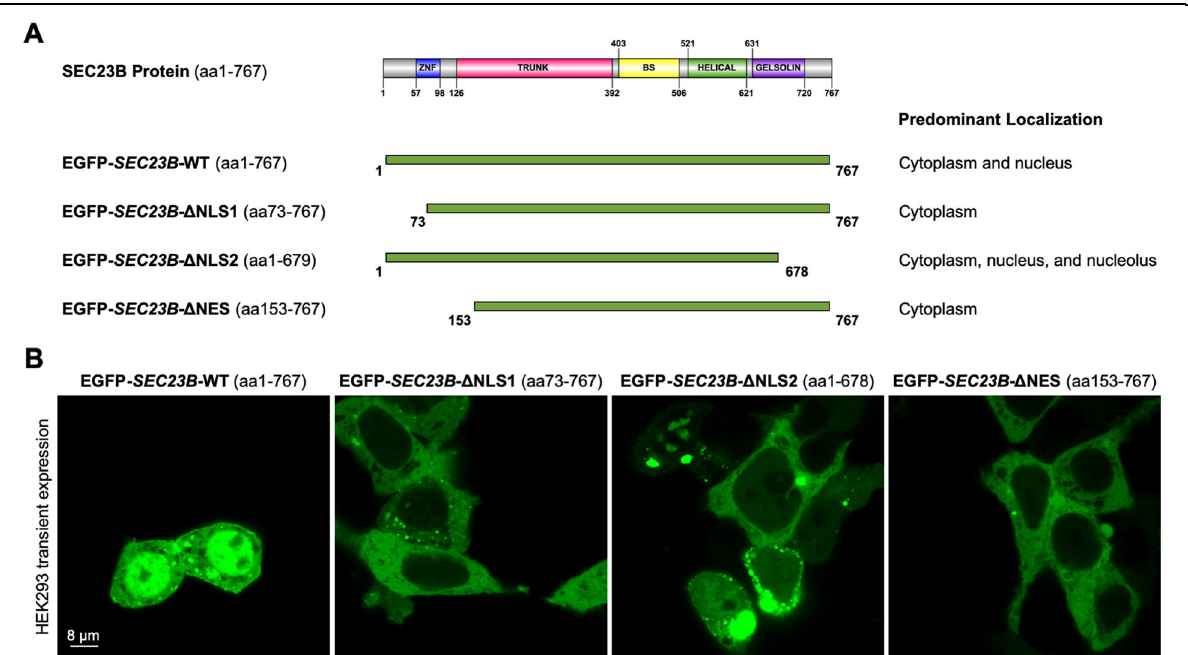
Fig. 2 Characterization of putative SEC23B nuclear localization and export signals. A Truncation mutant constructs generated to characterize the bioinformatically top scoring NLS sequences and the single predicted NES sequence. The full-length SEC23B protein (Uniprot Q15437, SC23B_HUMAN) is depicted in the top panel. aa amino acids. B Confocal microscopic images of HEK293 cells transiently transfected with each of the constructs. The corresponding localization of the SEC23B protein is summarized in A . The predicted NES overlaps with the predicted NLS1 sequence. Scale bars, 8 μ